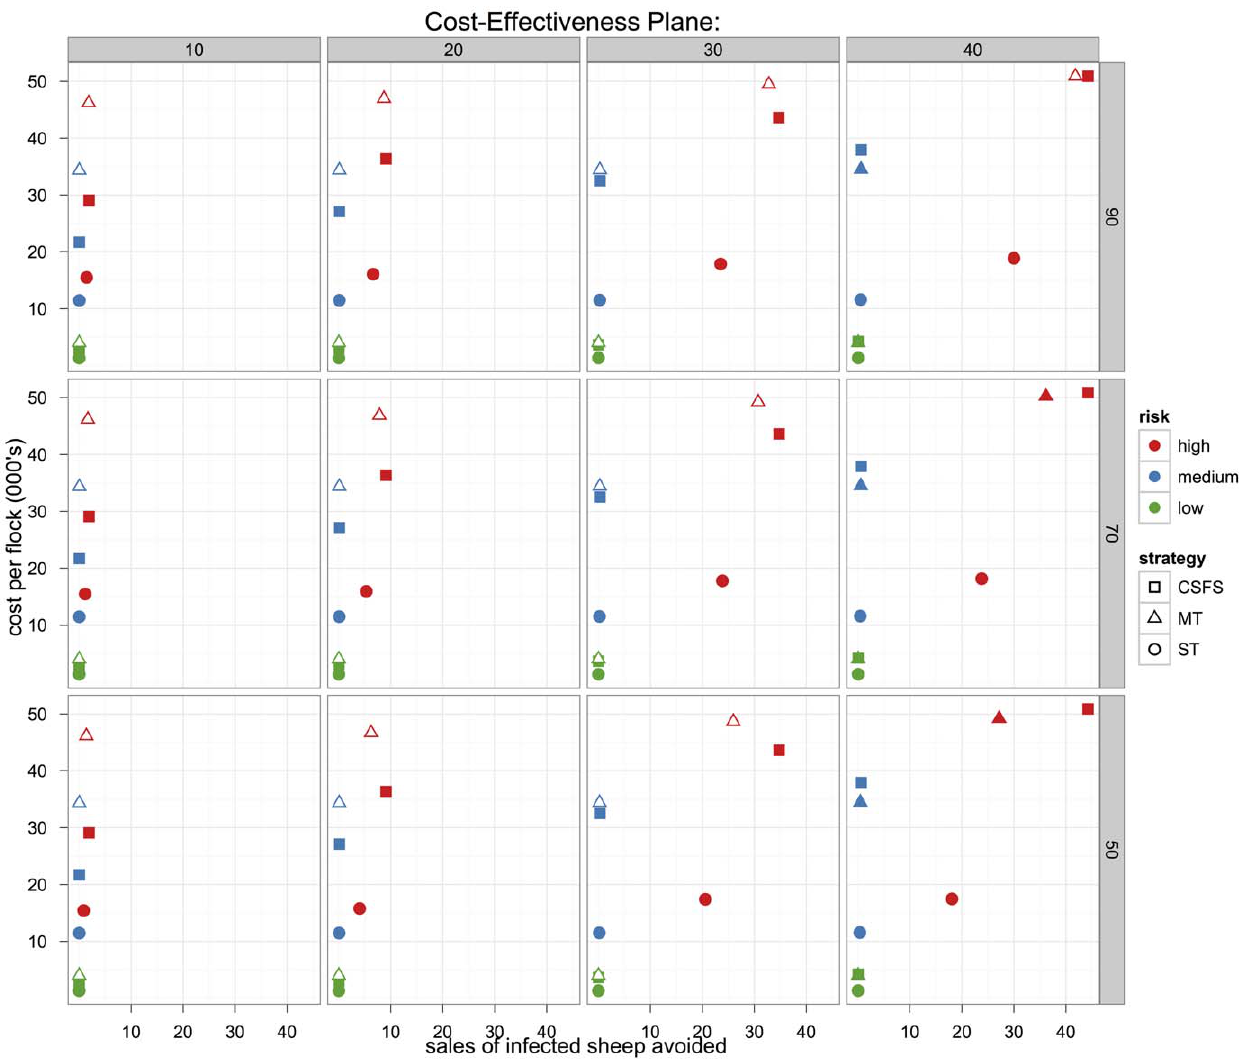
Figure 2. Cost-effectiveness plane examining all flocks (high, moderate and low risk) with different proportions of susceptible genotypes. In this analysis, we have found the unit cost of pre-clinical testing that makes the total CSFS and MT (including compensation, labour and testing) equivalent costs. The cost effectiveness planes vary by test sensitivity (rows 50–90%) and proportions of susceptible genotype (columns 10–40%) The outlined points on the plot represent dominated strategies. The origin in each panel represents no intervention. In high-risk flocks, the CSFS and MT are more efficient than the single test strategy (ST) at high proportions of susceptible genotypes within the flock (i.e. . 30%). At lower proportions of susceptible genotypes (i.e. # 30%) in high risk flocks, MT is the dominated strategy. MT has to be cheaper, and this is exacerbated if prevalence or test sensitivity drops.